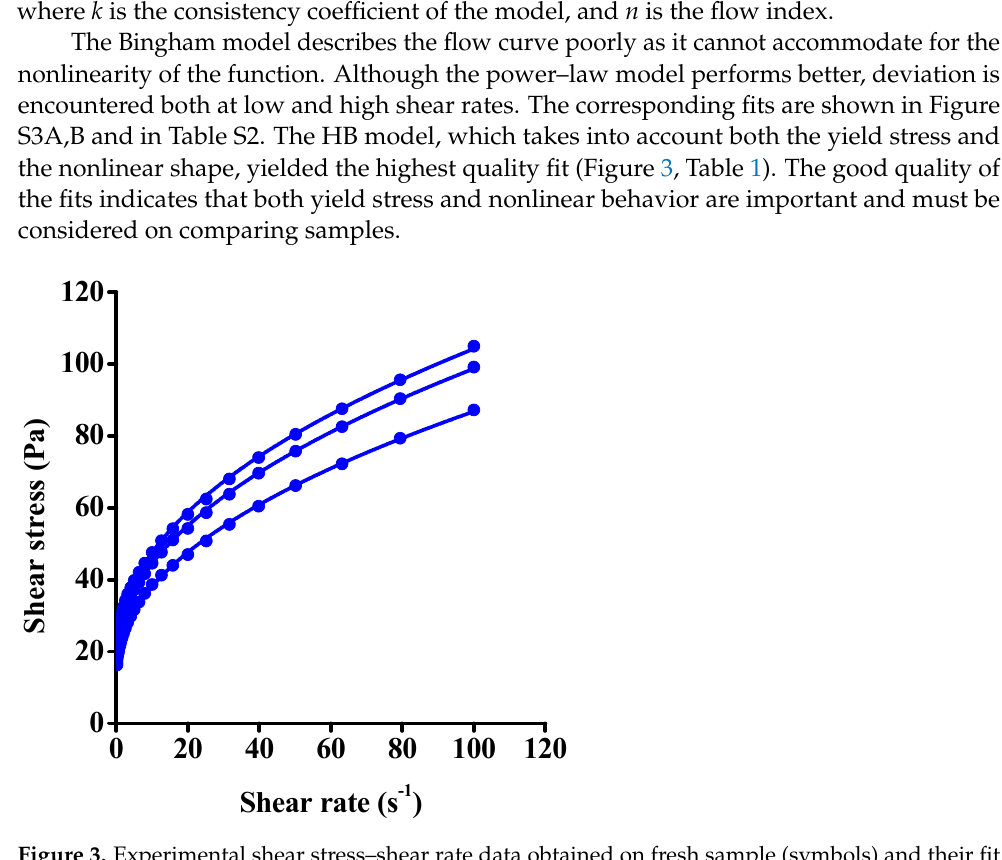
Figure 3. Experimental shear stress–shear rate data obtained on fresh sample (symbols) and their fit to the Herschel–Bulkley model (lines). Table 1. Fitted parameters from the Herschel–Bulkley